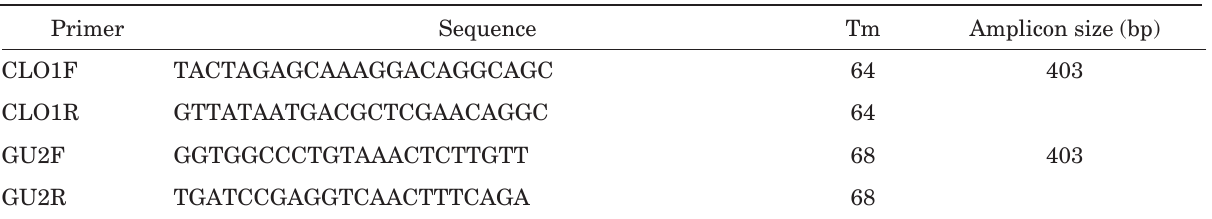
Table 3. Sequences of primers, melting temperatures (Tm), and size of amplicons used in this study.